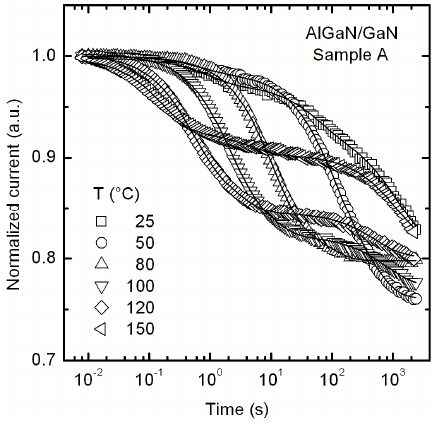
Figure 3. Current transients of the AlGaN/GaN. structure of Sample A measured at a reverse bias of − 6 V at various temperatures. Full lines are fitting curves.